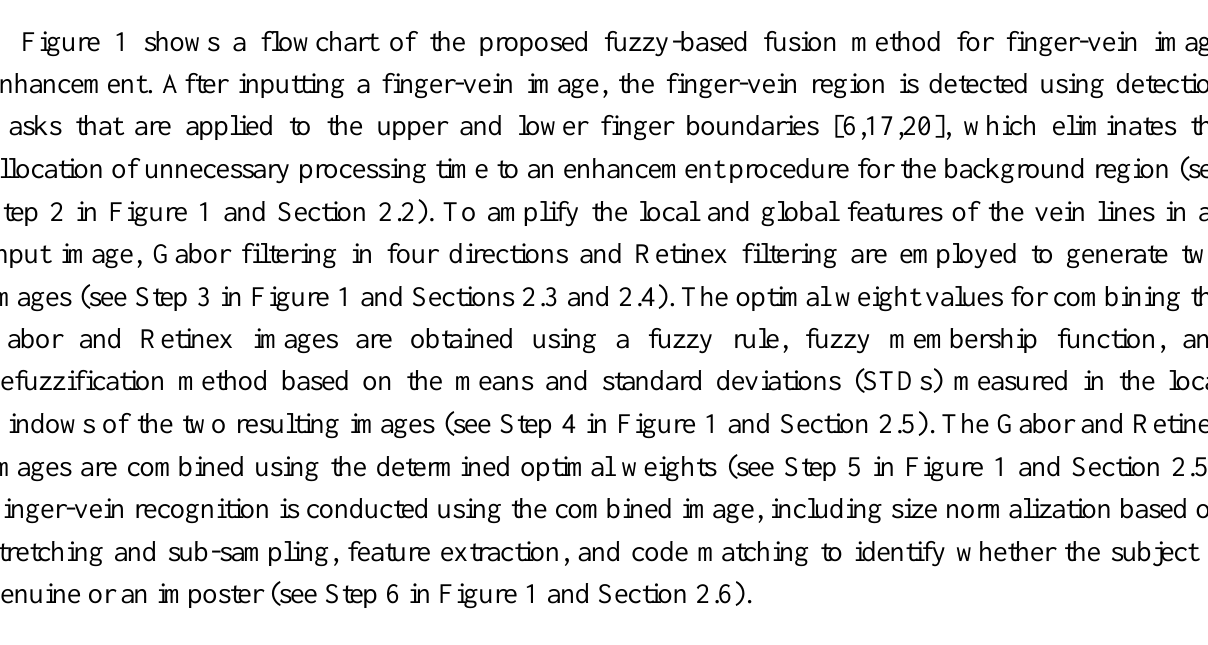
Figure 1. Flowchart showing the proposed fuzzy-based fusion method for finger-vein image